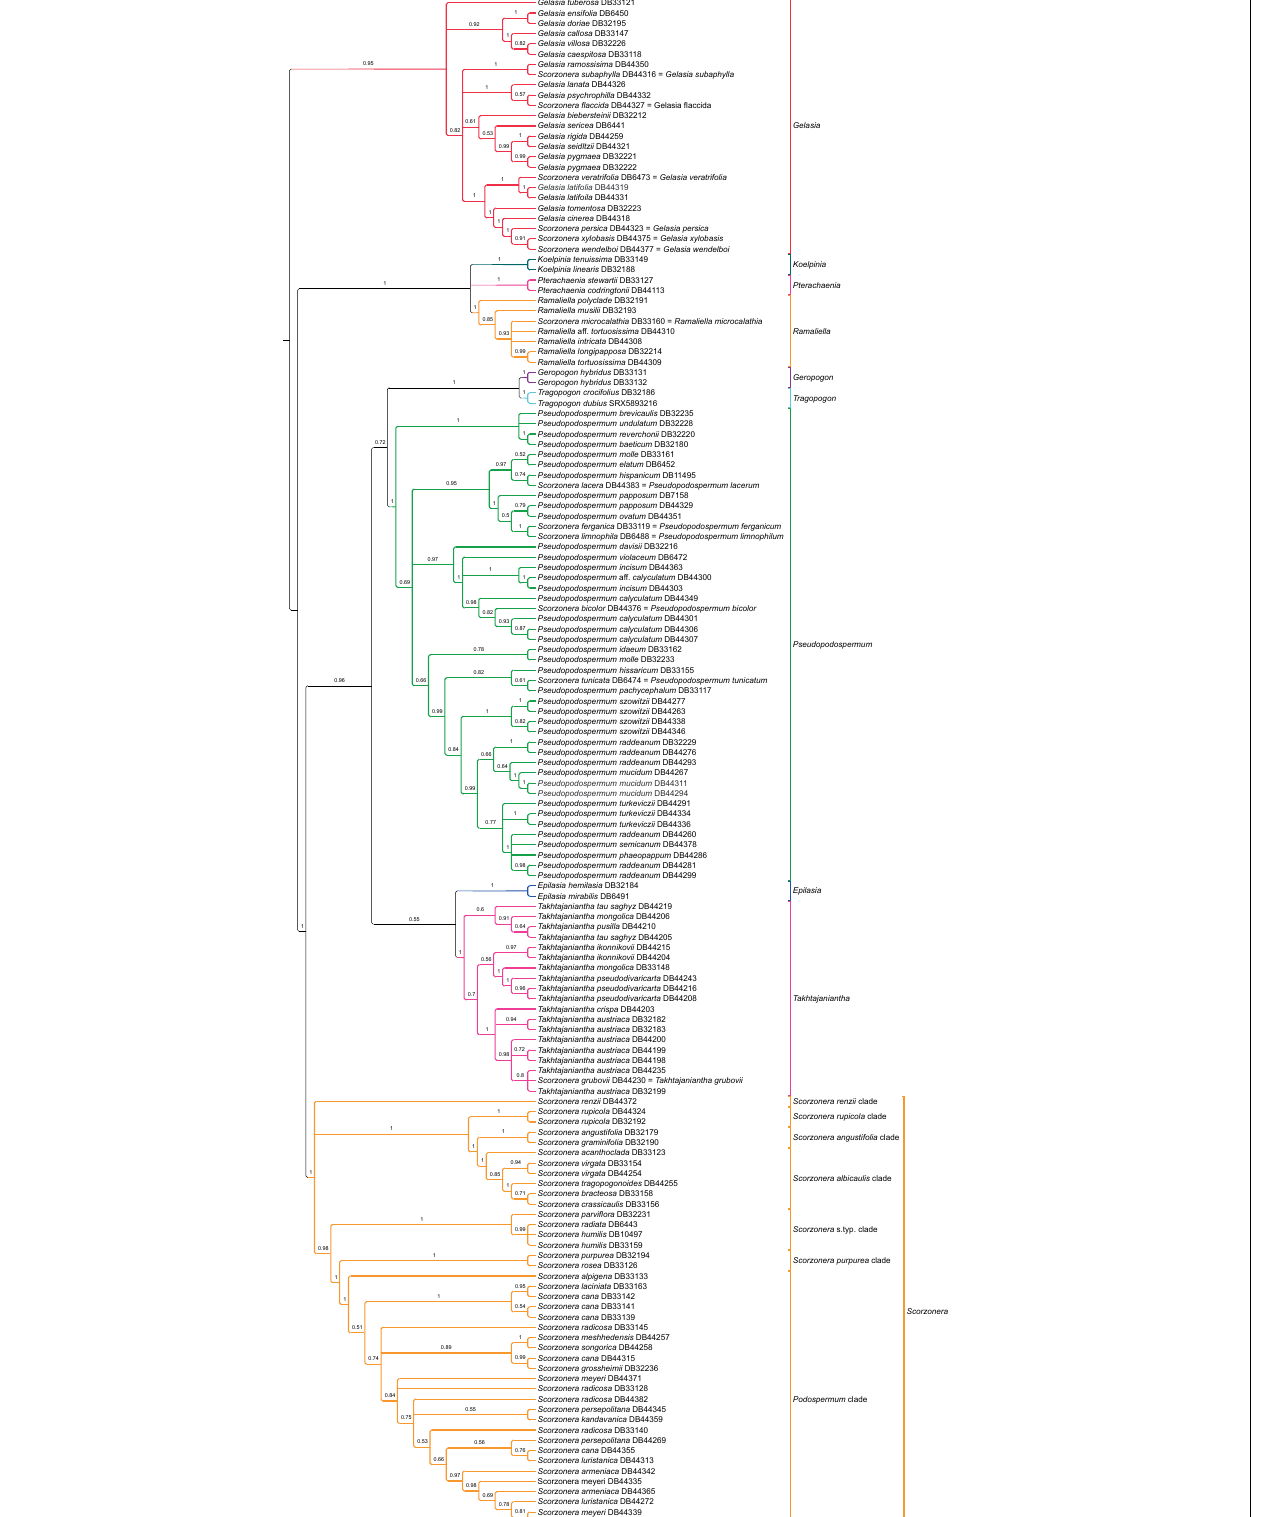
Frontiers in Plant Science |